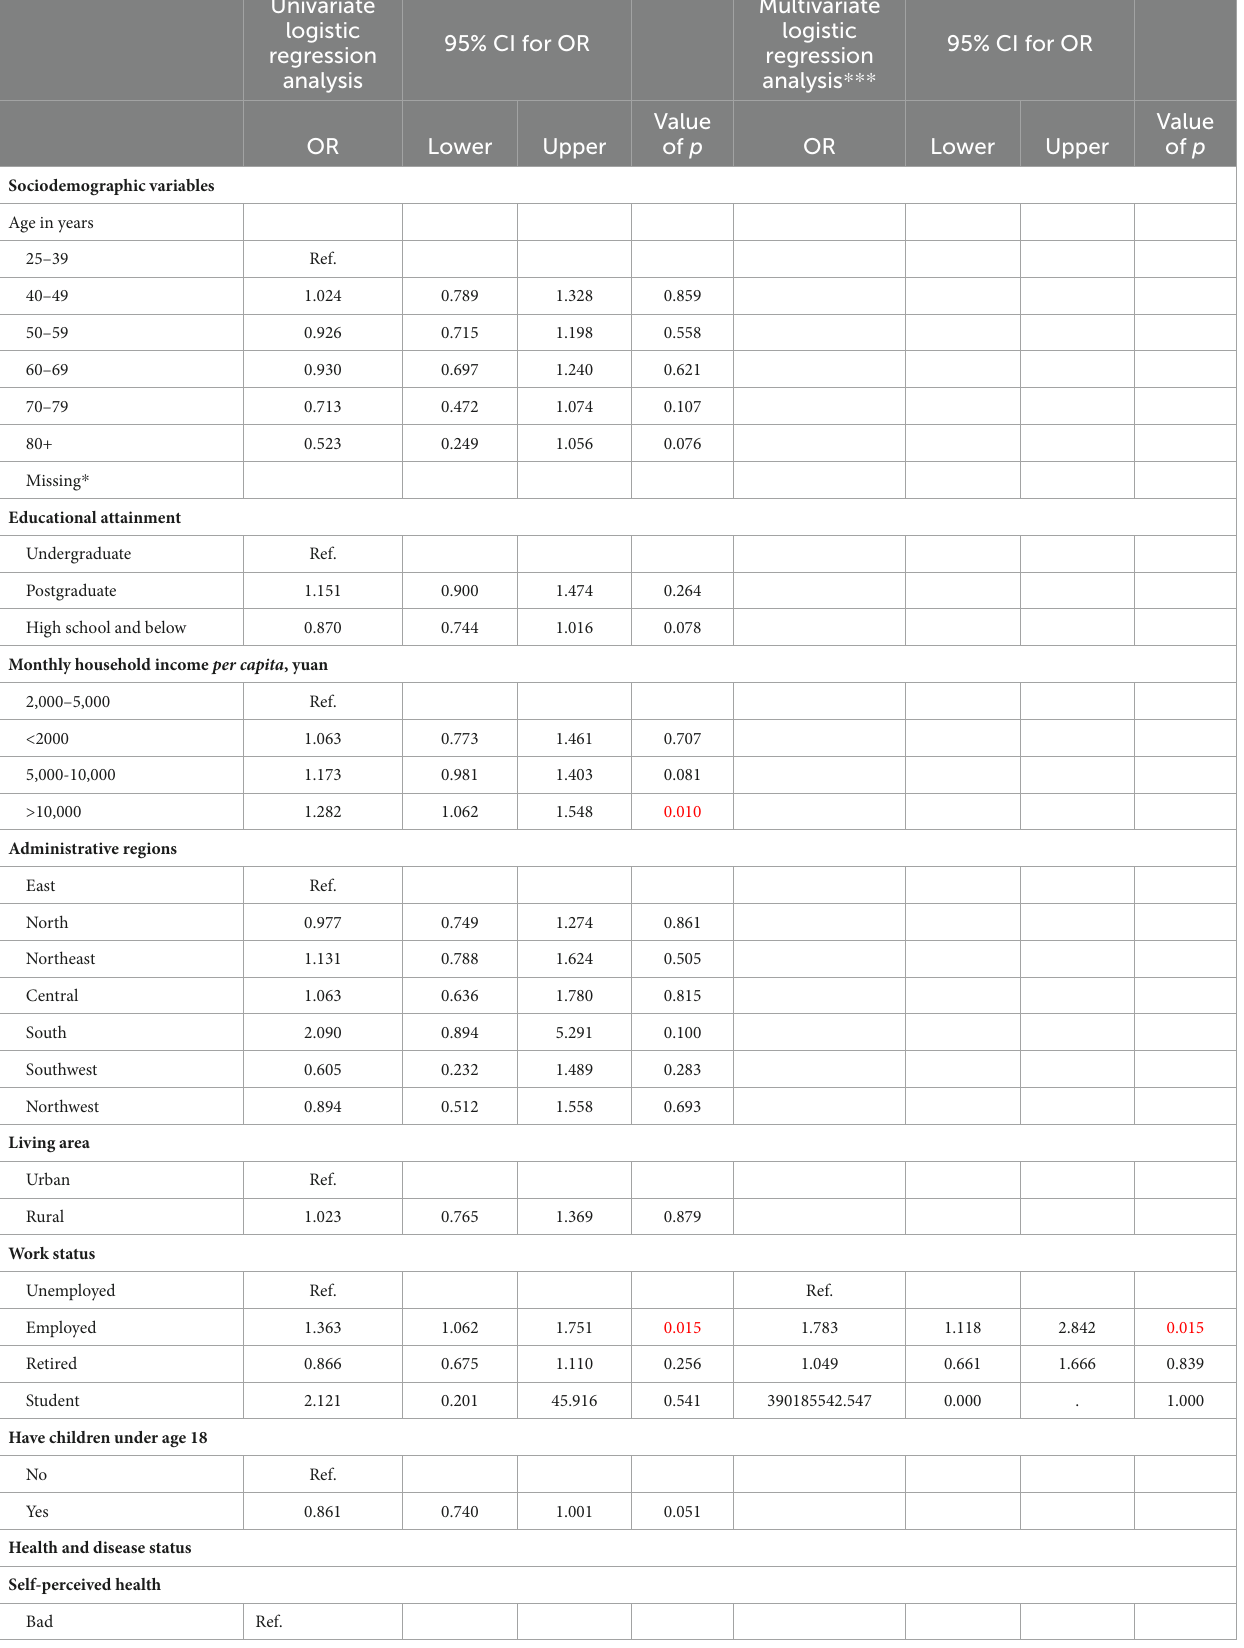
TABLE 2 Univariate and multivariate logistic regression of characteristics for association with vaccination status.